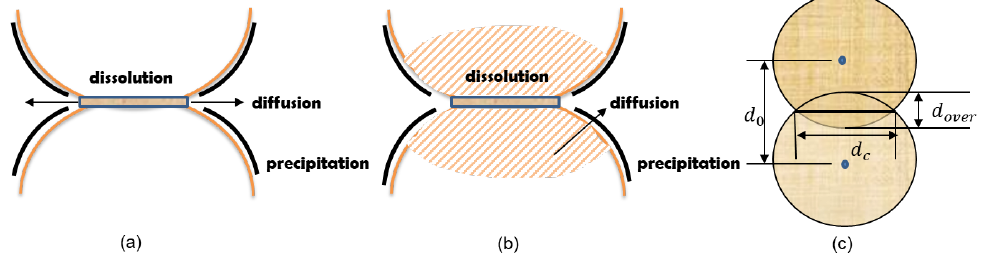
Figure 1. ( a ) Schematic representation of mineral dissolution focused the contact area, as commonly proposed in pressure solution theory [30,31]. ( b ) Schematic representation of an enhanced dissolu- tion mechanism that considers the near-contact localized deformation and damage [19]. ( c ) DEM configuration of particle contact with geometry parameters indicated for subsequent modeling